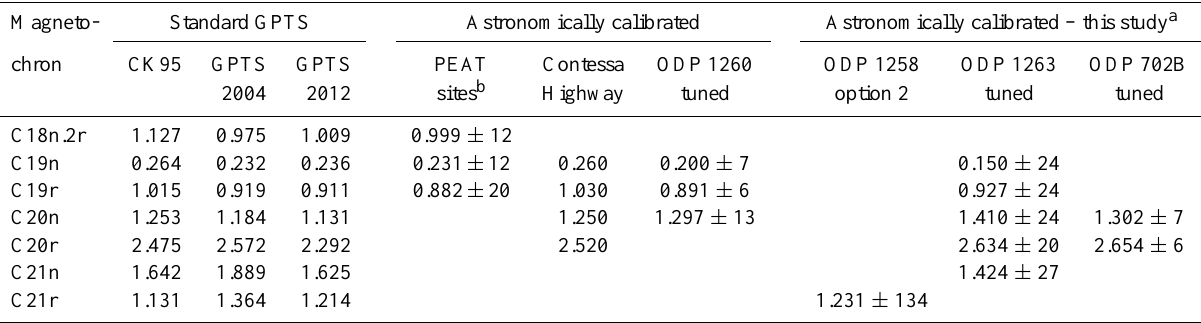
Table 2. Comparison of magnetochron boundary durations in millions of years. Magneto- Standard GPTS Astronomically calibrated Astronomically calibrated – this study